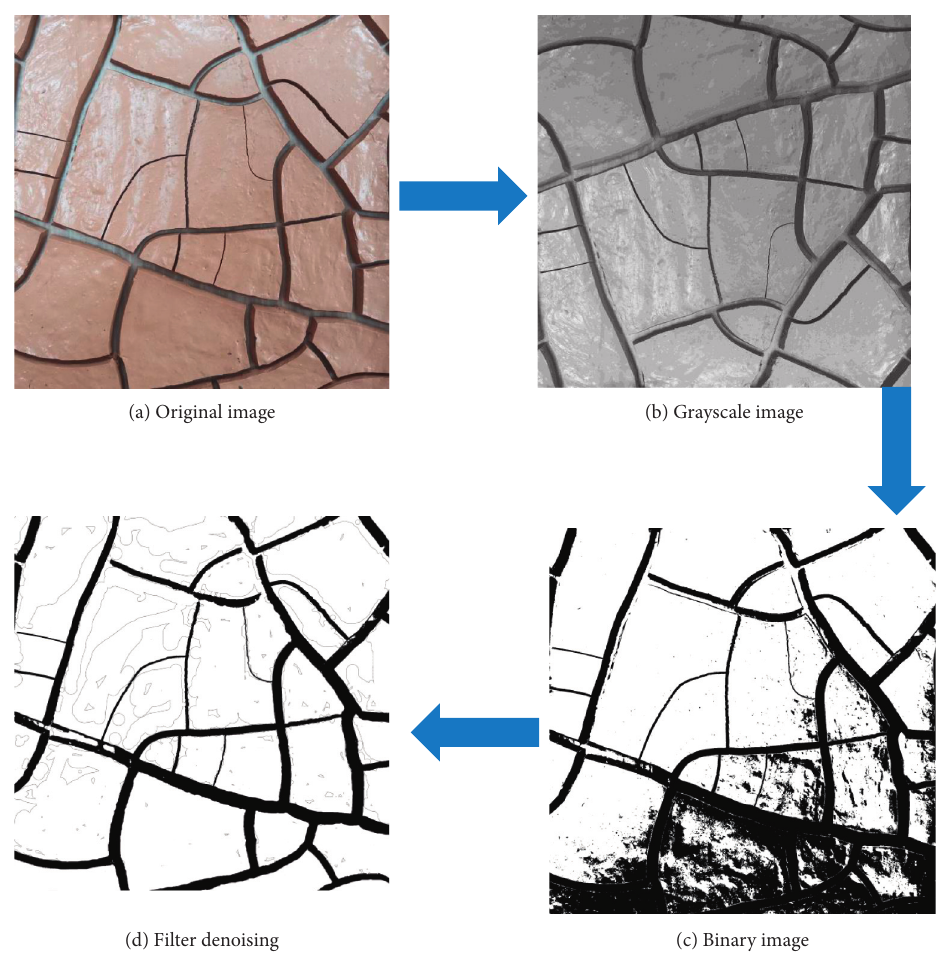
Figure 2: Image processing